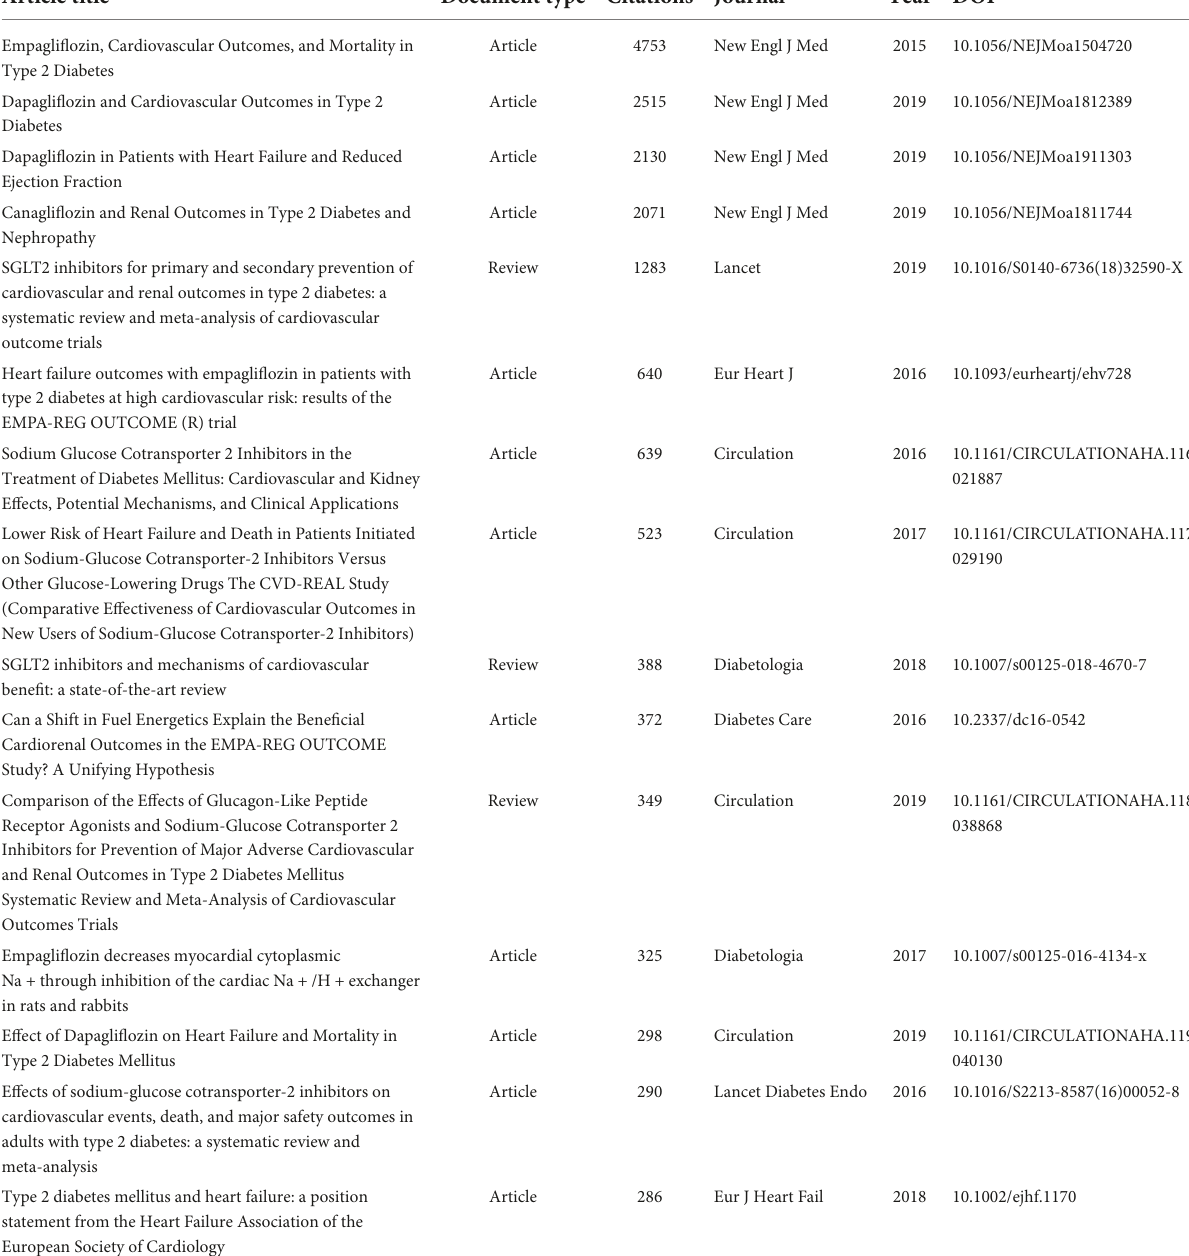
TABLE 8 The top 15 highly cited literatures in the field of EMPA for